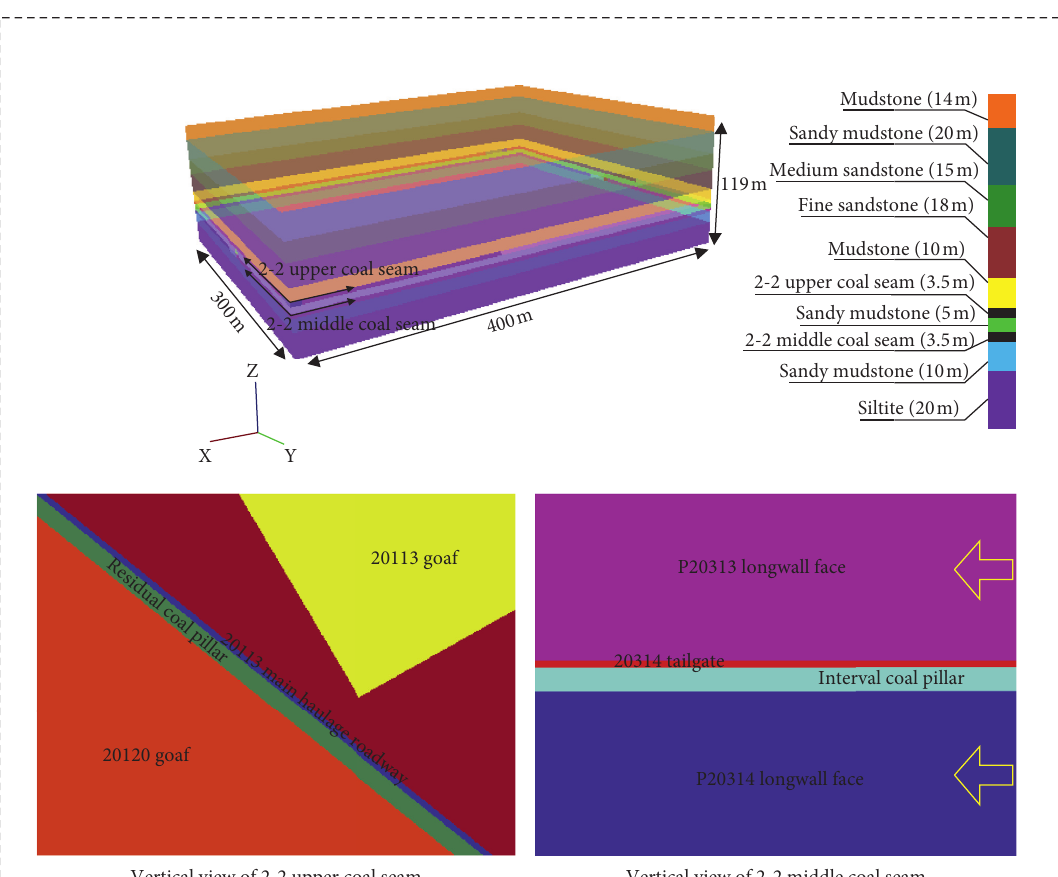
Figure 11: Numerical